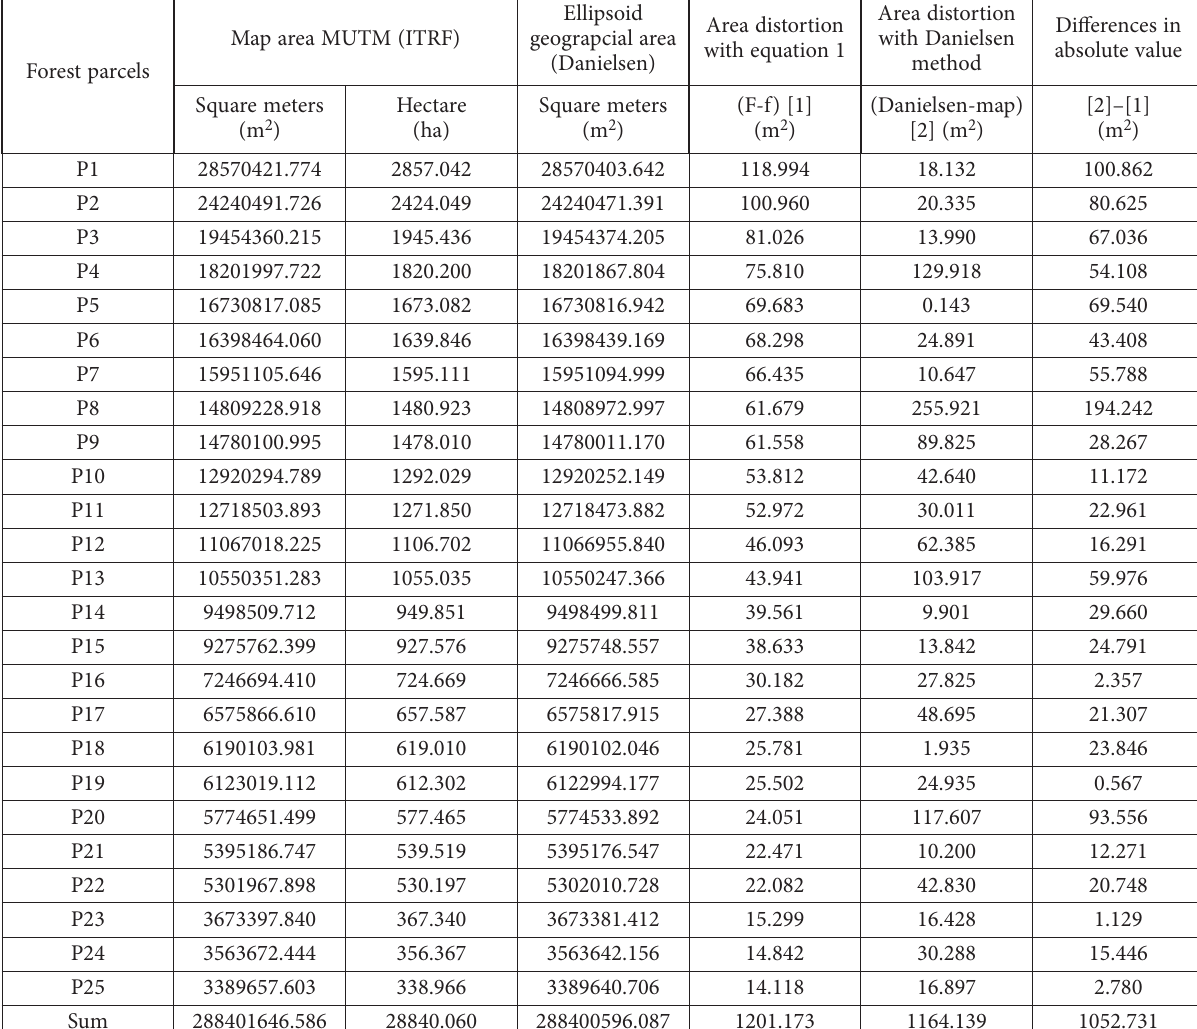
Table 1. MUTM map areas, area deformations and ellipsoid area values